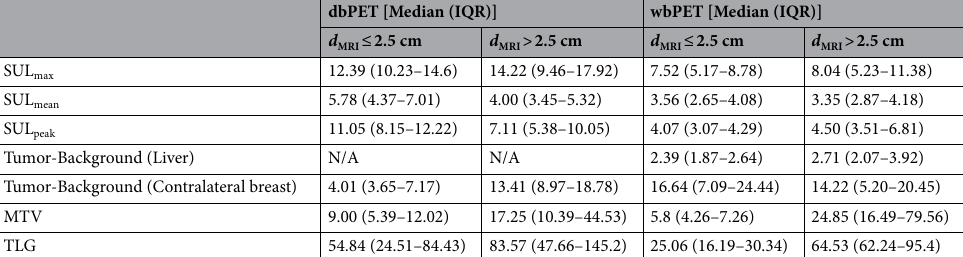
Table 2. Summary of dbPET and wbPET uptake metrics for MRI longest diameter ( d MRI ) ≤ 2.5 cm and d MRI > 2.5